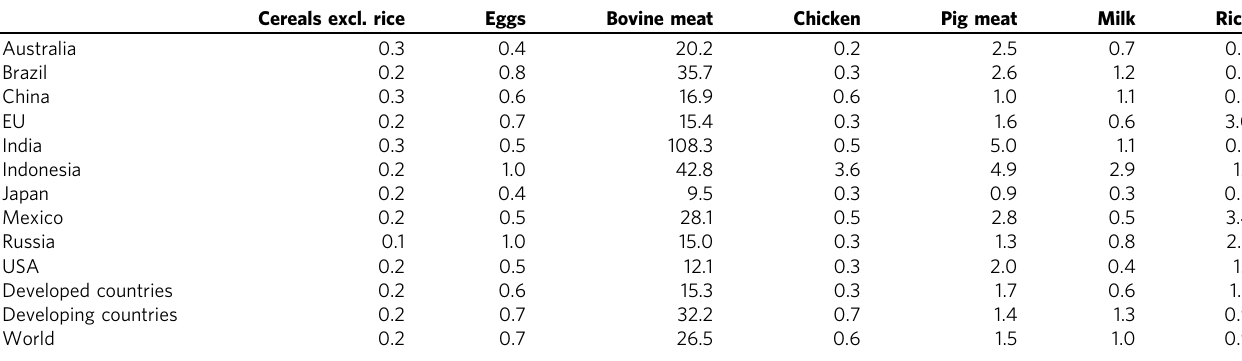
Table 3 Emission intensities for key products, countries, and country groupings, 2013 – 2015 (kg CO 2 eq. per kg of production). Cereals excl. rice